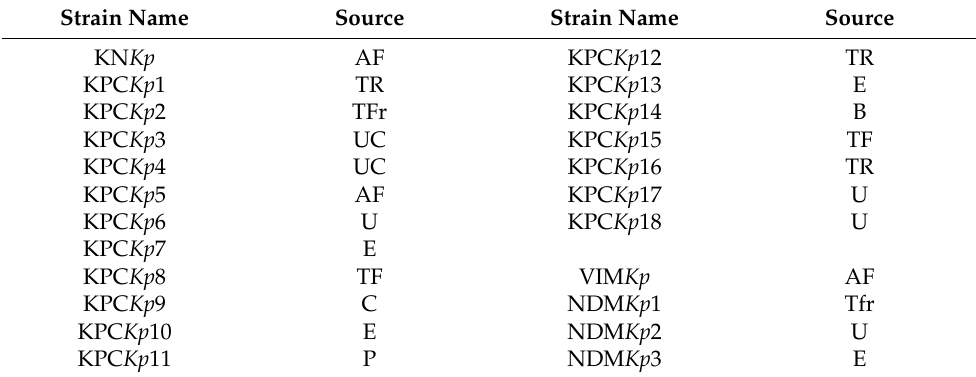
Table 1. K. pneumonaie clinical strains used in antimicrobial assays. Strain Name